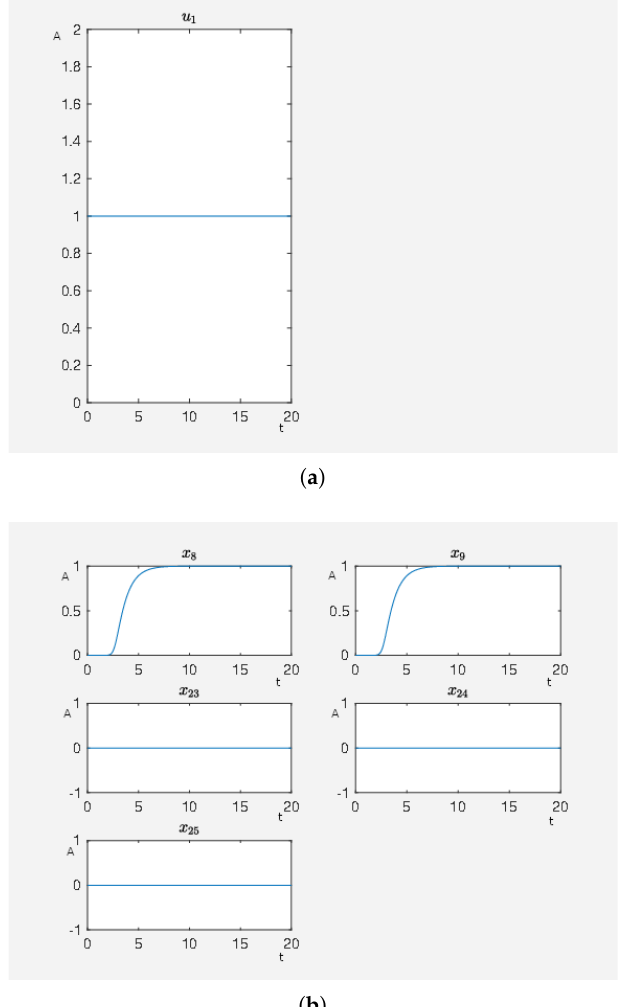
Figure 4. A non-hypertrophic stimulus with carbachol. ( a ) Time curve of the external stimulus where u 1 activates carbachol. On the abscissa, we have the time (t) and on the ordinate the activity level (A). ( b ) Time curve of the nodes of interests where x 8 is the activity level of p90RSK, x 9 is the activity level of p70S6K, x 23 is the activity level of Elk1, x 24 is the activity level of MSK1 and x 25 is the activity level of c-Myc. On the abscissa, we have the time (t) and on the ordinate the activity level